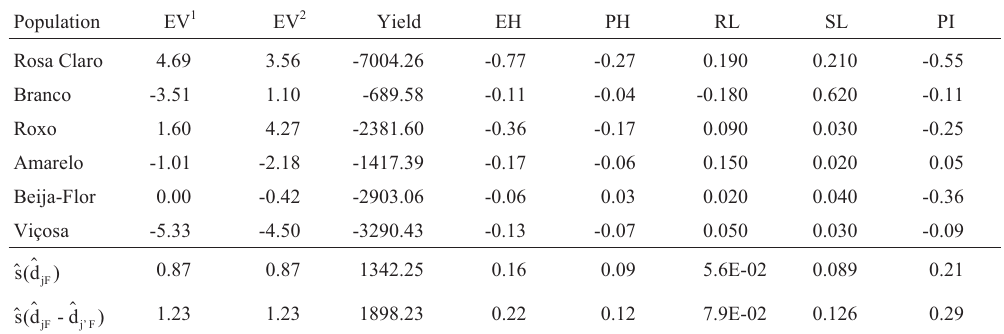
Table5 -Estimatesofchangesinthegenotypicmeansofpopcornpopulationsforexpansionvolume(EV,mL/g) 1 ,yield(kg/ha),plantheight(PH,m),ear height (EH, m), proportion of root lodged plants (RL), proportion of stalk lodged plants (SL) and prolificacy index (PI), and standard deviation estimates of the effects and